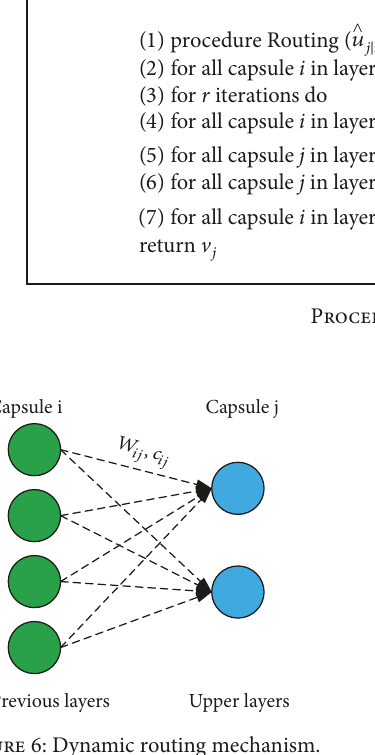
Figure 6: Dynamic routing